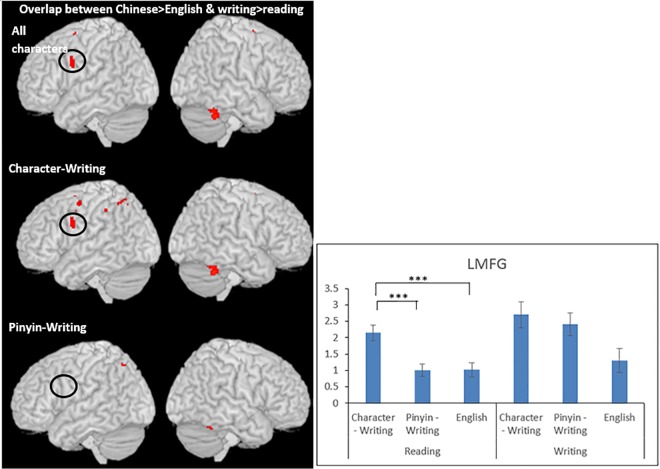
Overlap between Chinese greater than English and writing greater than reading.The results are presented for all Chinese characters, Chinese characters learned in the character-writing condition and characters learned in the pinyin-writing condition for the English L1 participants. Bar graph shows the brain activation at the left middle frontal gyrus at (-50, 2, 28) in each task for characters learned in either character-writing or pinyin-writing and for English words. *** indicates significance at p < .001. Error bars indicate standard errors.